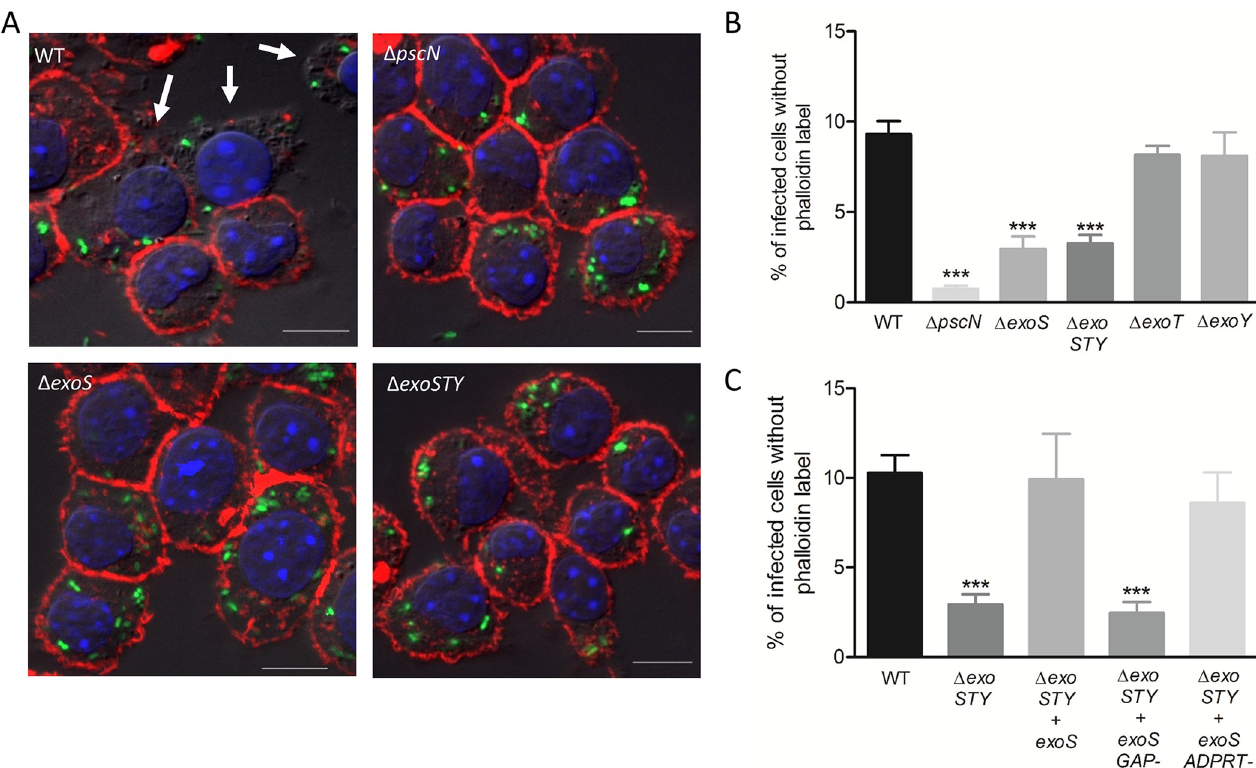
Fig 6. Assessment of role of T3SS and its effectors in cell lysis induced by intracellular PAO1. J774 macrophages were infected with GFP expressing strains as indicated. After phagocytosis, cells were maintained in DMEM supplemented with gentamicin. Cells were imaged 2 hrs post-phagocytosis after staining with phalloidin (A). Scale bar is equivalent to 10 μ m. Lysis was quantified (B & C) by counting infected cells lacking cortical labeling (indicated by arrows). Percentage of lysed cells with intracellular bacteria out of total number of infected cells was plotted. Error bars correspond to standard errors from at least three independent experiments. At least 200 cells were counted per strain. The asterisks indicate P values (One way ANOVA, where all strains were compared to WT using Dunnett’s multiple comparison test, ��� P < 0.001), showing statistical significance with respect to WT.